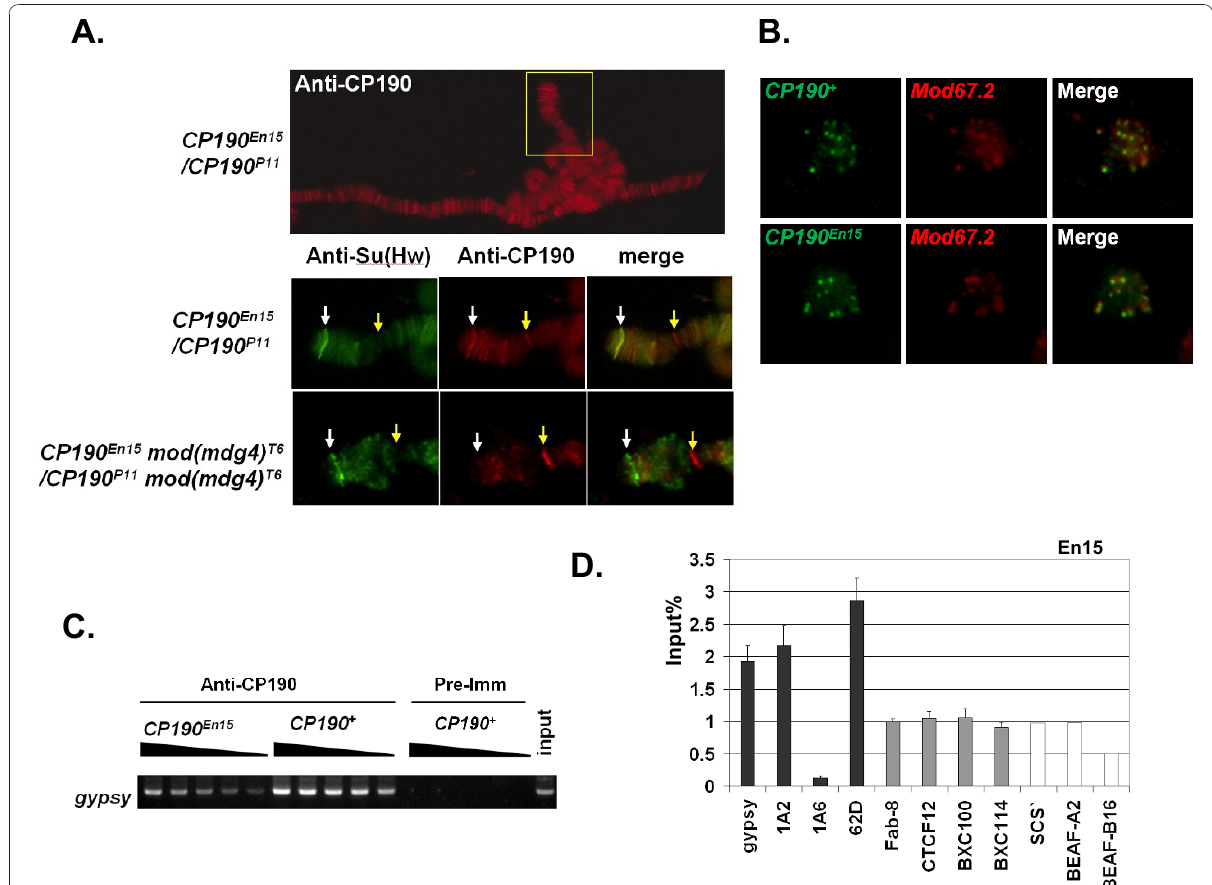
Figure 5 The Cp190 fragment lacking the C-terminal E-rich domain localizes to Cp190-containing nuclear complexes . (A) Polytene chromosomes from y 2 ; CP190 En15 /CP190 P11 (top and middle panels) and from y 2 ; CP190 En15 mod(mdg4) T6 /CP190 P11 mod(mdg4) T6 (bottom panel) 3 rd instar larvae were stained with anti-Su(Hw) (green, left column) and anti-Cp190 (red, middle column) antibodies. Merged images are shown on the right. The middle panel is the closer view, rotated 90 degrees counter clockwise, of the area indicated by the yellow square in the top image. White arrows point to the y locus at the tip of the X chromosome. Yellow arrows point to the Cp190-positive band at the constriction of the cytological location 3C. (B) Diploid cells of brain tissues from CP190 + flies (top) or from the CP190 En15 /CP190 P11 (bottom) flies were stained with anti-Cp190 (green, left column) and anti-Mod(mdg4) (red, middle column) antibodies. Merged images are shown on the right. (C) The gypsy fragment amplified by PCR from anti-Cp190 precipitated chromatin from y 2 ; CP190 En15 /CP190 P11 pupae (left lanes, labeled CP190 En15 ) and from y 2 ; CP190 + pupae (middle lanes). The gypsy fragment amplified from the pre-immune serum precipitated y 2 pupae (right lanes, labeled CP190 + and Pre-Imm) was the negative control and the gypsy fragments amplified from non-precipitated total y 2 pupal genomic DNA (labeled as input on top) was the positive control. The black triangles indicate two-fold serial dilutions of the amount of the chromatin sample used in each PCR reaction. More volumes of the indicated template were in the PCR reactions on the left as indicated by the thicker part of each triangle. (D) The anti-Cp190 ChIP of y 2 ct 6 ; CP190 En15 flies analyzed by Real-Time PCR. The same loci tested in Figure 3 ChIP assays were analyzed and were shown as percentage of input DNA (n ≥ 3). The results of all regions were normalized to Fab-8